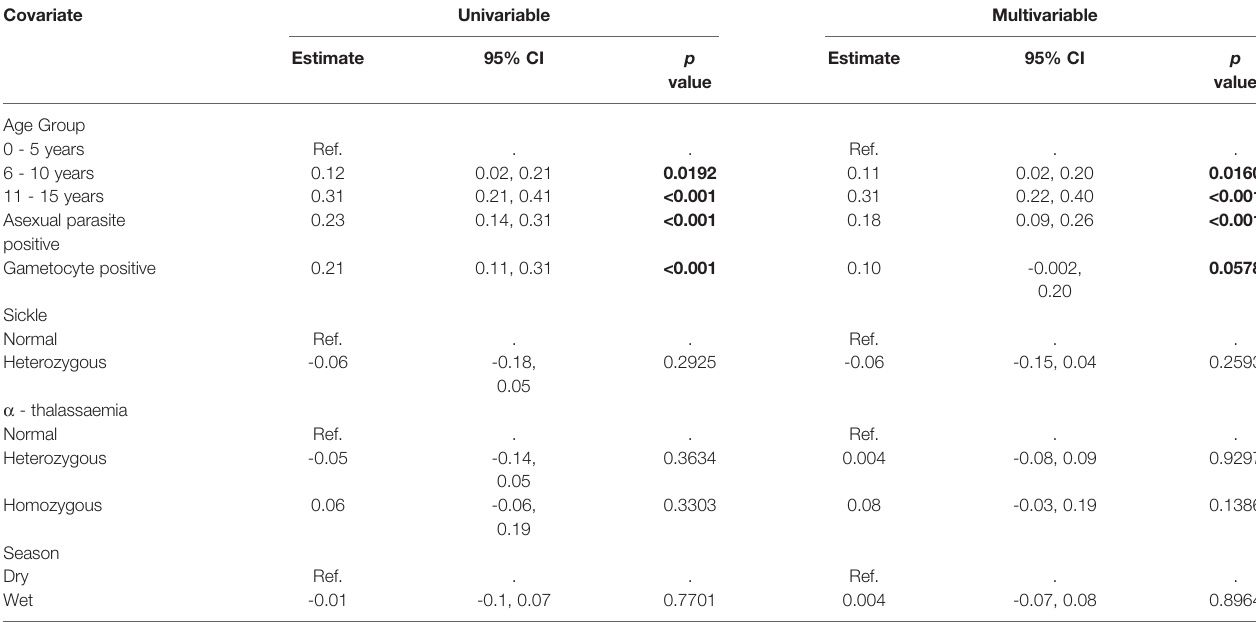
TABLE 6 | Linear regression analysis of the factors in fl uencing the number of antigens recognized by the study participants – AFIRM cohort.